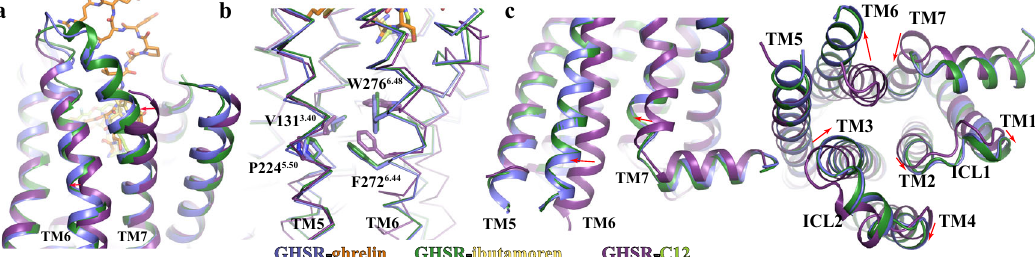
Fig. 3 Active conformation of GHSR. Conformational changes of the extracellular regions of TM6 and TM7 ( a ), the highly conserved transmission switch residues ( b ), and cytoplasmic regions of TMs ( c ) in the active GHSR relative to them in the inactive GHSR. Two active GHSR bound to ghrelin and ibutamoren and the inactive GHSR bound to C12 (PDB code 6KO5) are colored in blue, green, and purple, respectively. Ghrelin, ibutamoren and C12 are shown as orange, yellow and lemon sticks, respectively. Red arrows indicate changes of residues or regions from inactive to active